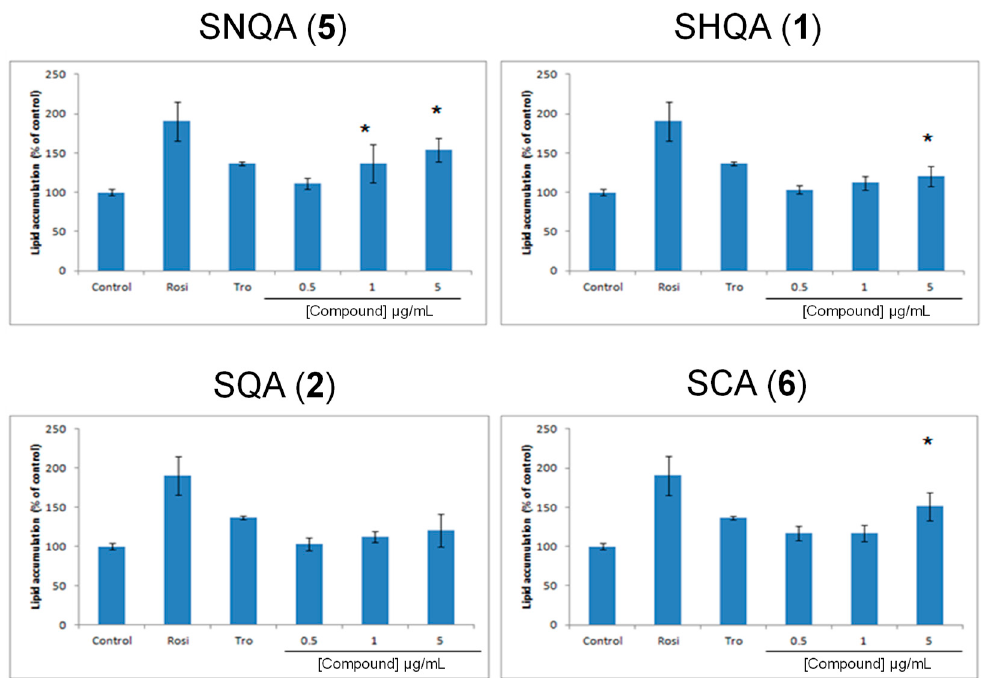
Figure 3. Dose ‐ dependent lipid accumulation in differentiating 3T3 ‐ L1 cells after treatment with sargahydroquinoic acid ( 1 ), sargaquinoic acid ( 2 ), sarganaphthoquinoic acid ( 5 ), and sargachromenoic acid ( 6 ). A total of 1 μ M each of rosiglitazone (Rosi) and troglitazone (Tro) was used as positive control. Each data point represents the mean ± SD (n = 3) while the asterisks (*) indicate a significant increase in lipid accumulation.